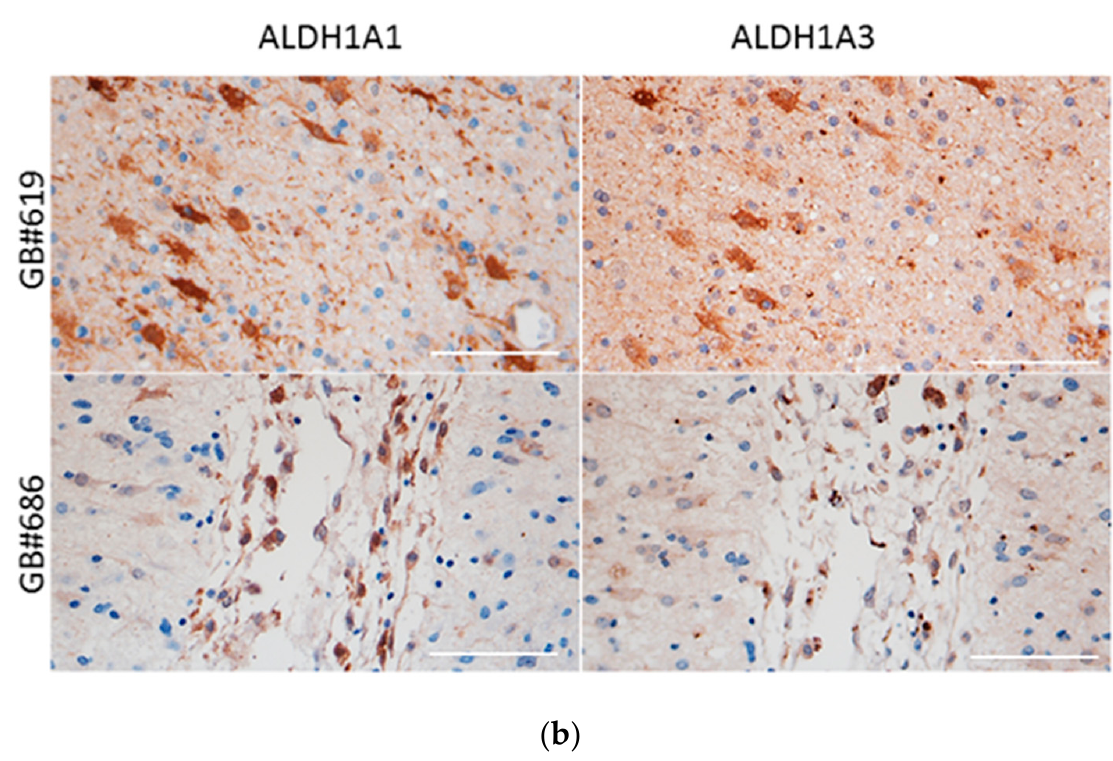
Figure 1. Immunohistochemical co-staining of GB tissues reveals either segregated ( a ) or concomi- tant ( b ) expression of ALDH1A1 and ALDH1A3 in tumor cells. Magnification 40×. Scale bar, 100 µm.